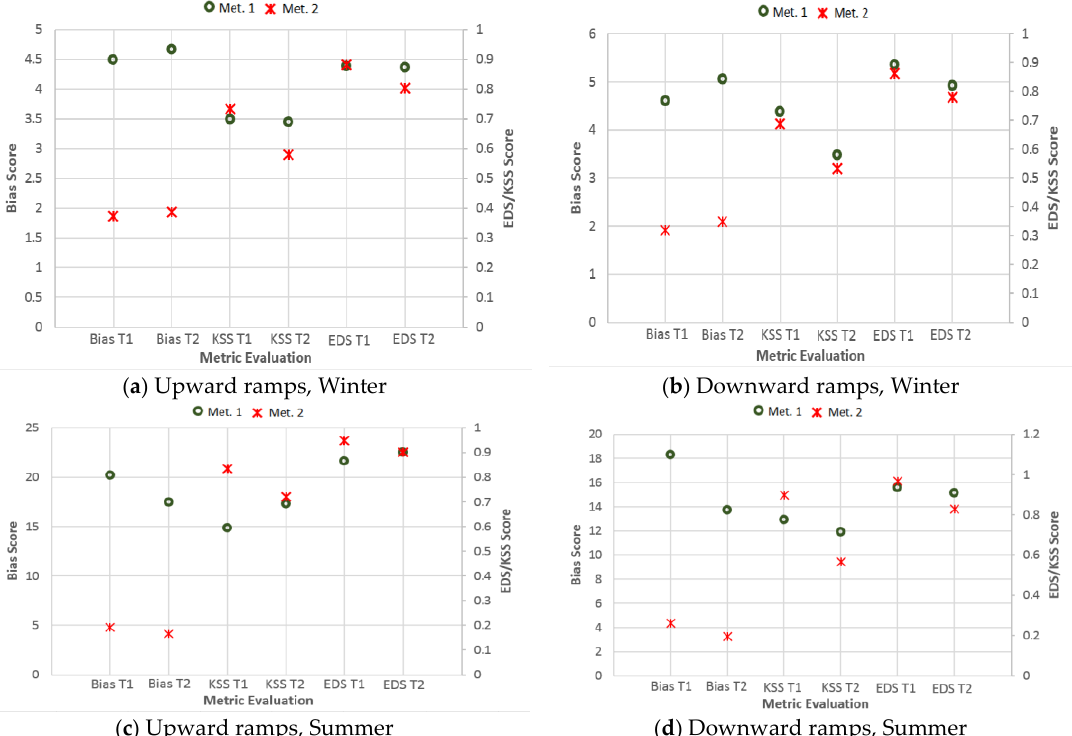
Figure 5. Evaluation metrics for: ( a ) Upward ramps during Winter months; ( b ) Downward ramps during Winter months; ( c ) Upward ramps during Summer months; ( d ) Downward ramps during Summer months.